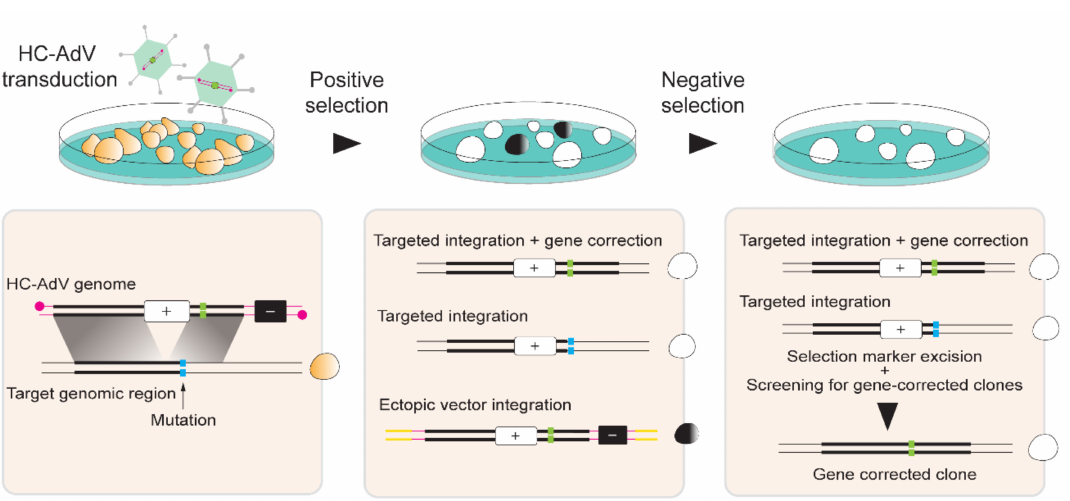
Figure 5. DSB-independent gene editing based on HC-AdV donor DNA transduction and positive-negative cell selection protocols. HC-AdV genomes contain a positive selection cassette, e.g., neo R (white box) flanked by extensive human DNA sequences that are homologous to a target genomic region except for specific nucleotide(s) (left panel). In this example, donor and acceptor templates bear wild-type and mutant allelic sequences of a target gene (green and cyan boxes, respectively) so that, after recombination, involving outward homologous regions, gene correction ensues (middle panel, upper diagram). Next to these wanted outcomes there are also unwanted ones in the form of homologous and non-homologous recombination events resulting in no gene correction and random chromosomal donor DNA integration (middle panel, central, and bottom diagrams, respectively). Cells containing these different types of genetic modifications survive and multiply in the presence of a cell-killing drug that is broken-down by the positive-selection gene product. Selective elimination of cells with random HC-AdV donor DNA insertions is accomplished owing to the presence of a suicide negative selection cassette located outside the homology regions, e.g., HSV-tk (black box), that convers a prodrug substrate into a cell-killing product. The positive selection marker can subsequently be removed by site-specific recombinases, e.g., Cre and FLP that leave lox P and FRT site footprints, respectively, in the genome. Alternatively, transposon / transposase systems, e.g., footprint-free PiggyBac variants can be used that ultimately achieve scarless genomic modifications. Finally, genotyping screens permit identifying cells containing correctly targeted alleles (right